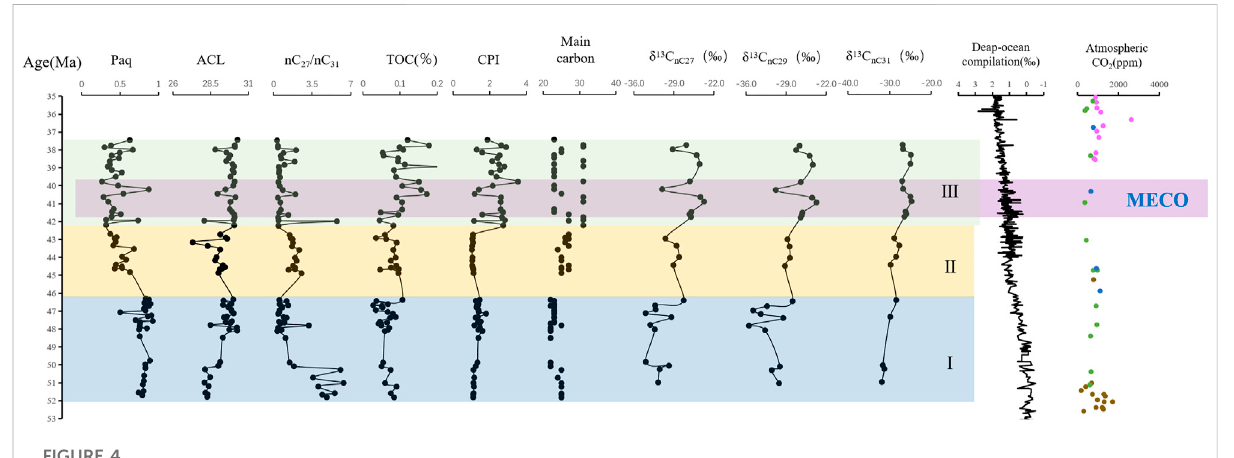
FIGURE 4 Comparison of n -alkane-derived indices in the Nangqian